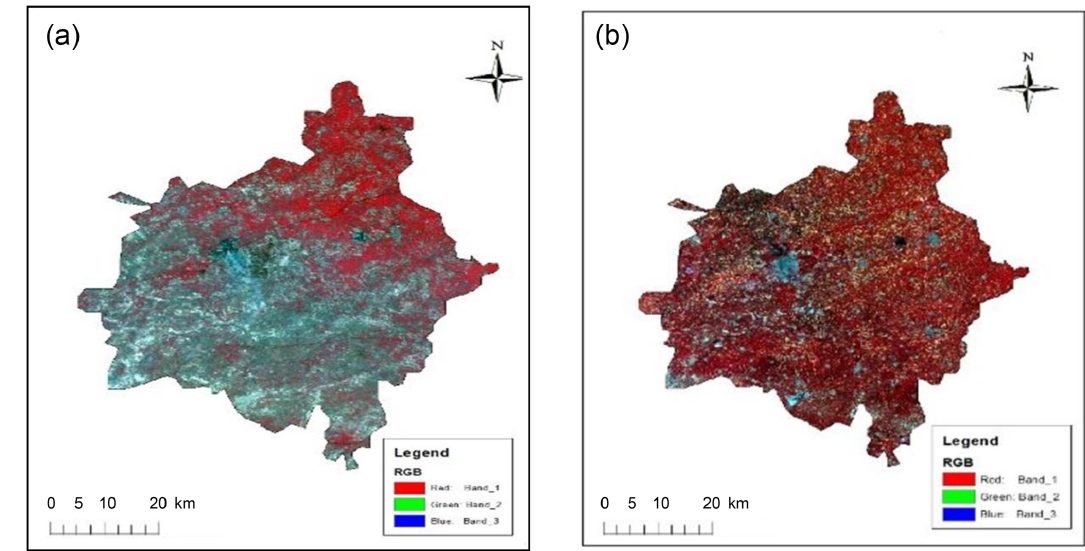
Figure 2. FCC of Landsat ETM + of (a) 2000 and (b) 2014.